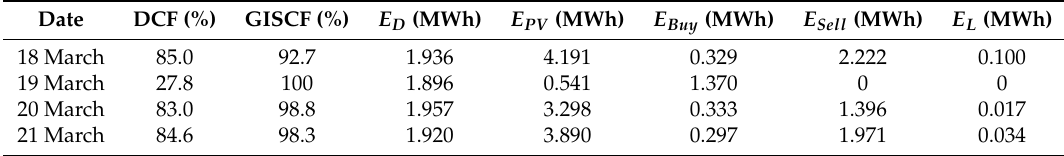
Figure 8. Aggregate results of 200 households with 3200 W of PV peak and 4000 Wh of energy storage installed each. Simulation from 18 to 21 March with 1-min resolution. Table 2. Indicator and energy figures for the aggregate simulation of 200